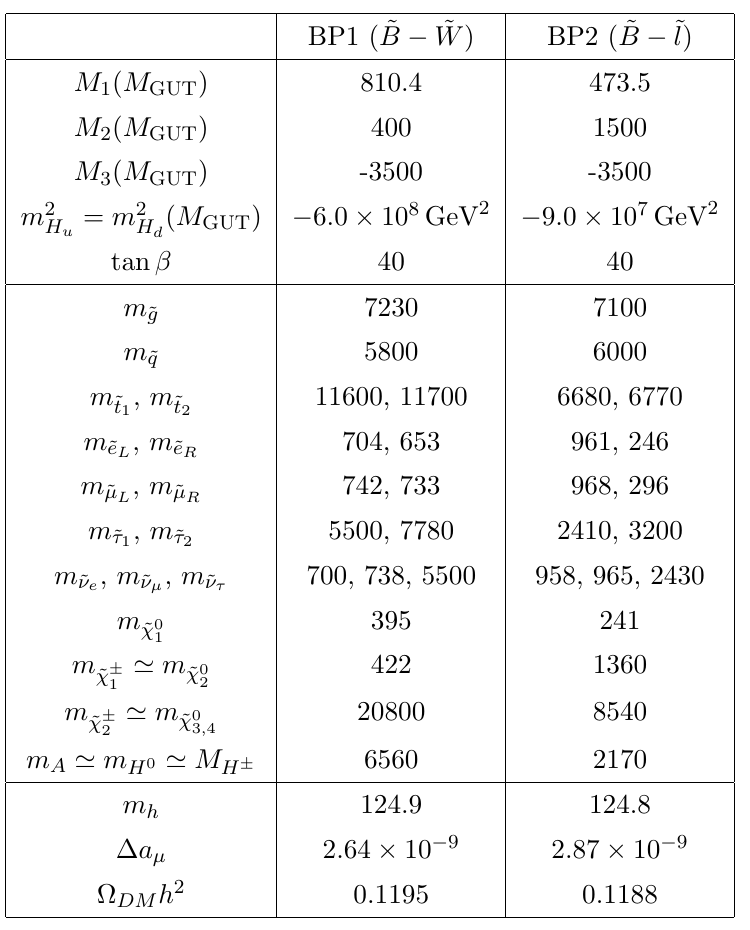
Table 2 . Complete spectra for two benchmark points corresponding to ~ B (cid:0) ~ W (BP1) and ~ B (cid:0) ~ l (BP2) co-annihilation. All masses are in